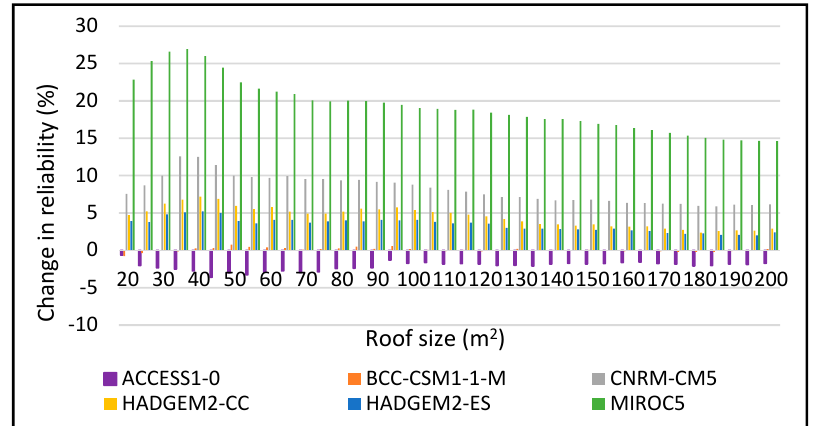
Figure 16. JJA Change in reliability for 2 m 3 during 2025–2055.